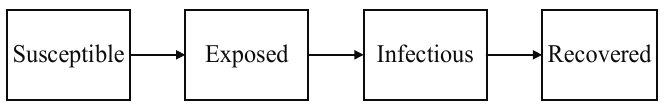
Figure 1. Traditional susceptible-exposed-infectious-recovered (SEIR) model.